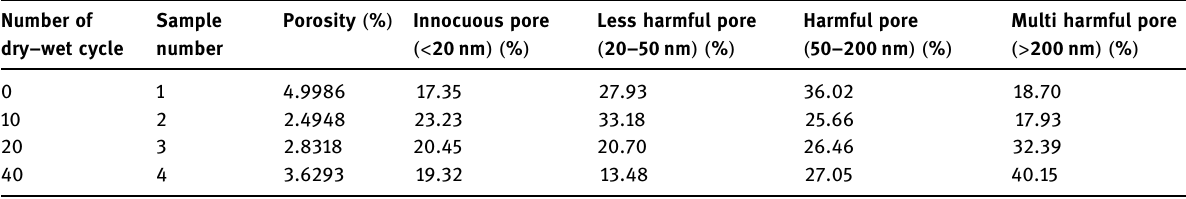
Table 2: Percentage of various types of holes in concrete at di ff erent dry – wet cycles [ 41 ]